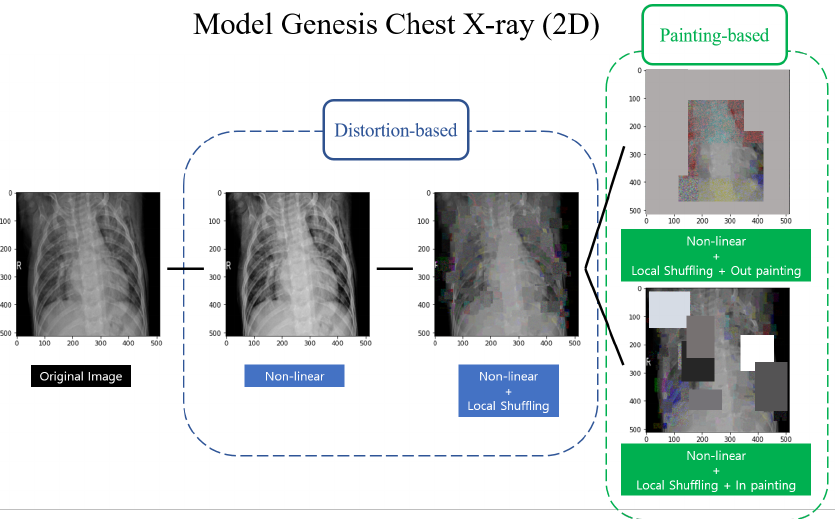
Figure 1. Example of transformed CXR (2D) by Models Genesis. CXR images are transformed using distortion-based and painting-based methods